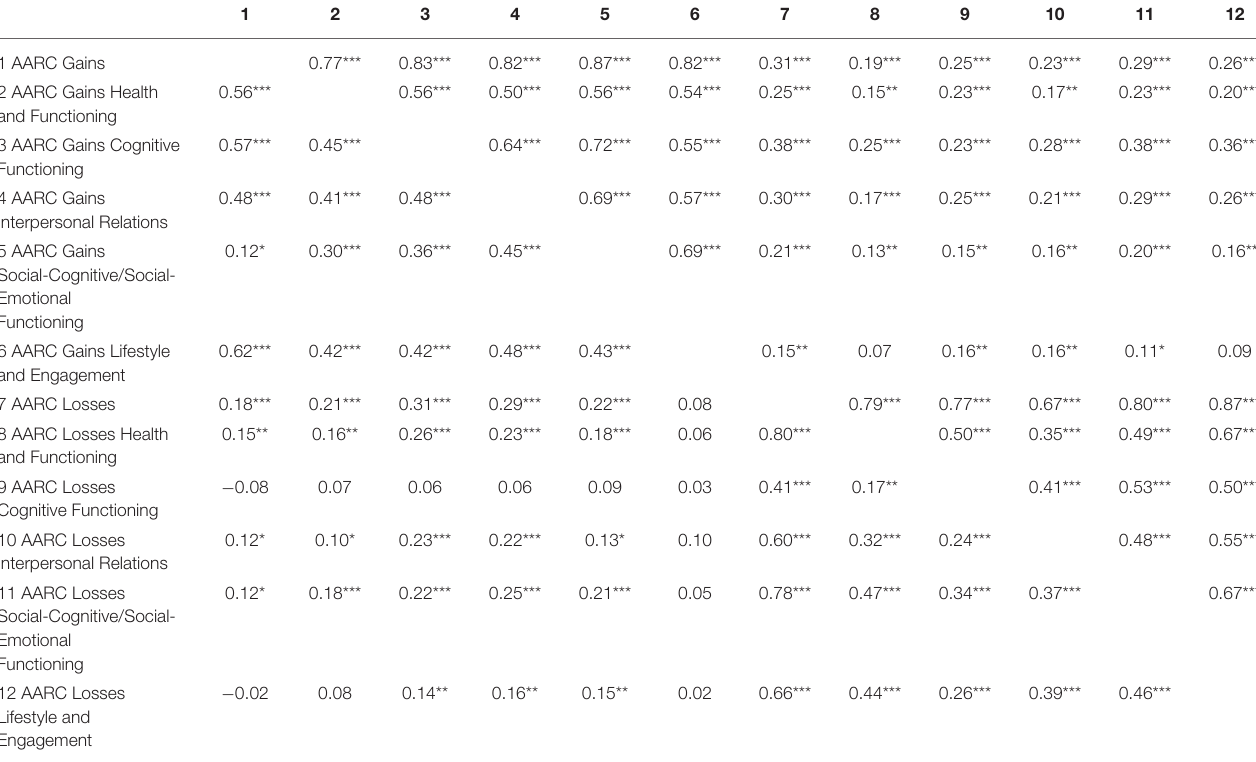
TABLE 3 | Associations between AARC